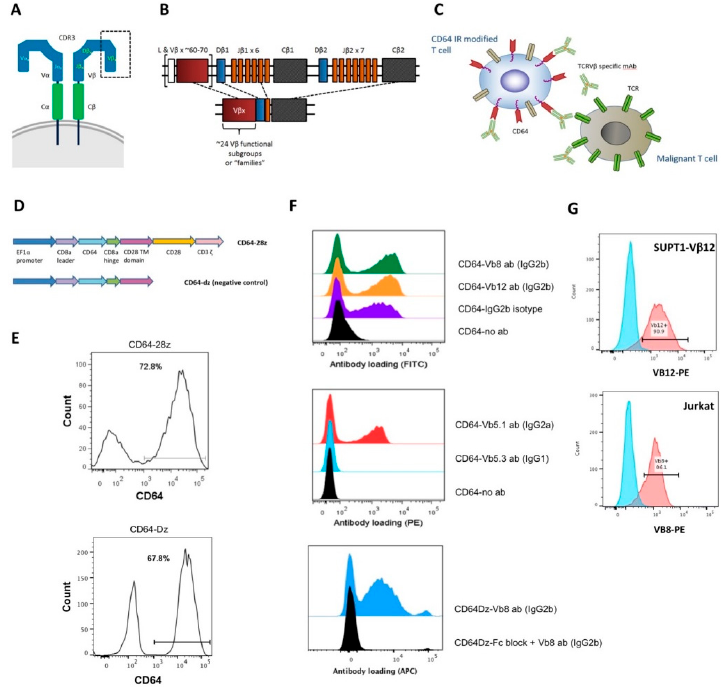
Figure 1. CD64 IR-modified T cells can be directed toward target T cells via TCRV β specific